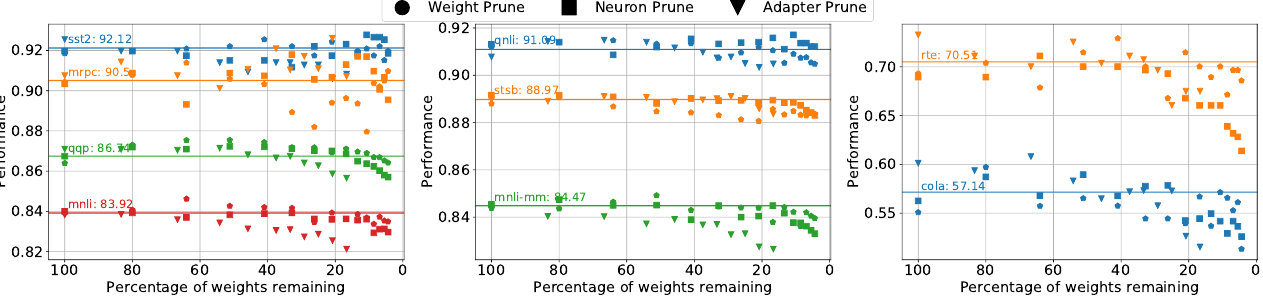
Figure 3. Performance of three different pruning schemes on GLUE validation sets at every pruning iteration. Horizontal line represents the performance of adapters before pruning starts. Each type of marker denotes a pruning